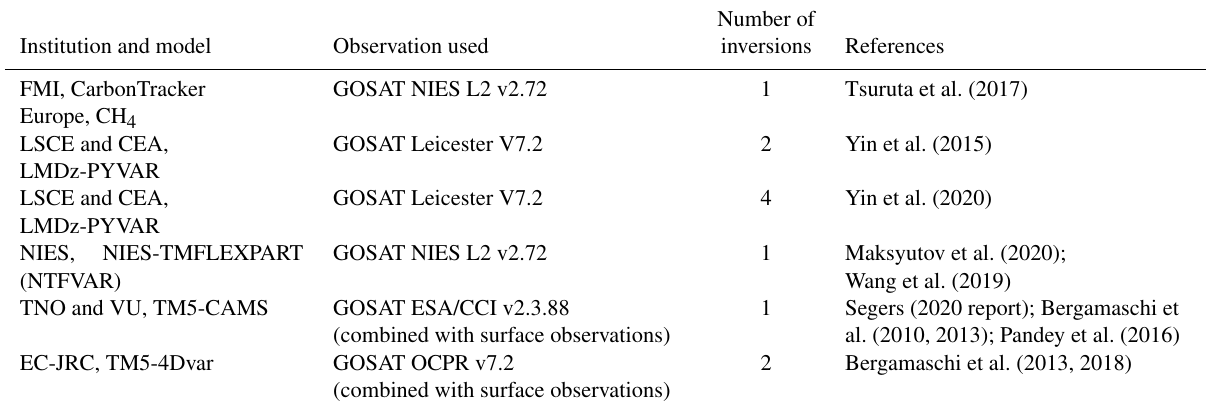
Table B1. List of the 11 methane inversions from the global methane budget (Saunois et al., 2020), as indicated by the column showing the number of inversions. All the details are presented in the references.